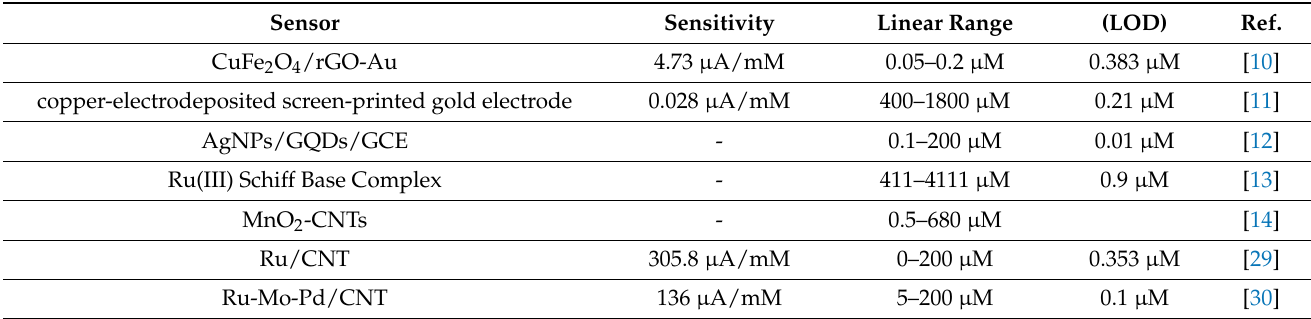
Table 1. Electrode materials employed in electrochemical determination of L-cysteine (L-C). Sensor copper-electrodeposited screen-printed gold